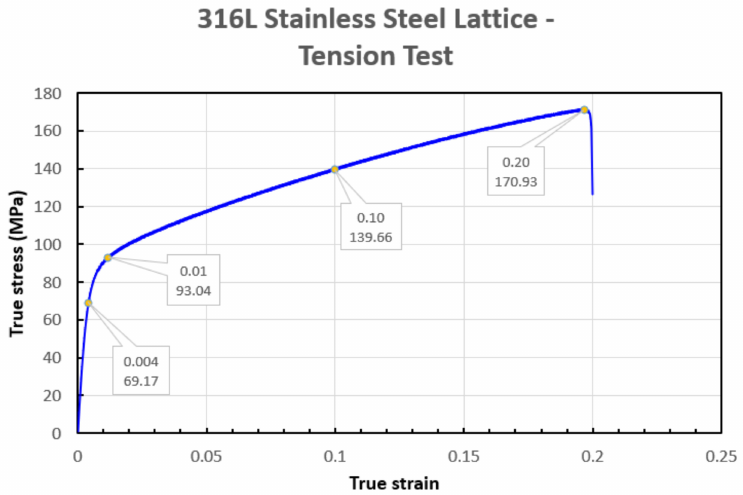
Figure 11. The experimental result of tension 316L stainless steel dog-bone lattice with four unique points marked out with true stress and true strain.